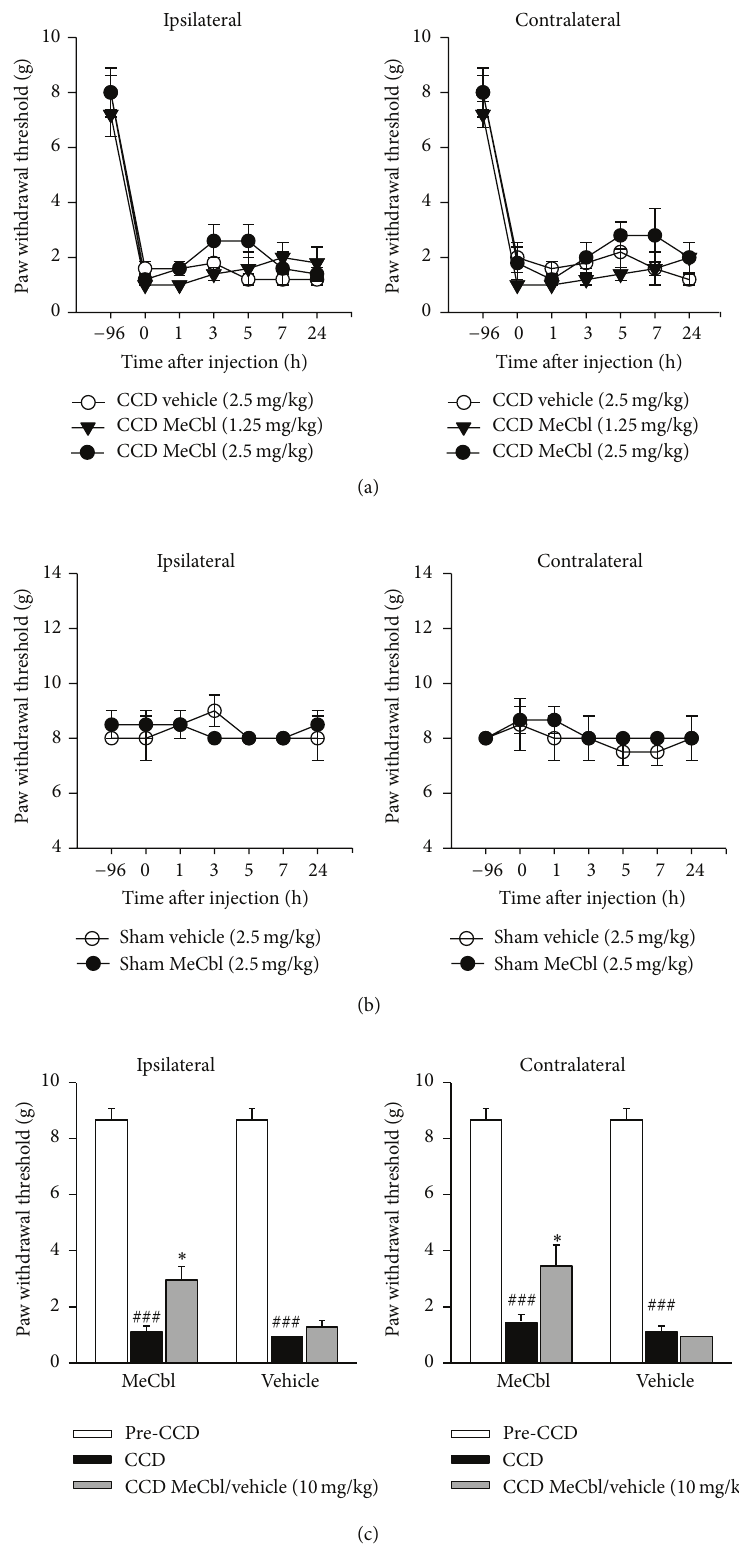
Figure 1: High dose of MeCbl ameliorated mechanical allodynia of rats following the CCD in the short term. MeCbl (1.25 mg/kg, 2.5 mg/kg, and 10mg/kg) was injected intraperitoneally on the postoperative 3 to 10 days. (a) Effects of MeCbl on ipsilateral and contralateral mechanical paw withdrawal thresholds in CCD rats following the injection. (b) No effects of MeCbl on ipsilateral and contralateral mechanical paw withdrawalthresholdsinshamrats.(c)AhigherconcentrationofMeCblaffectedbilateralpawwithdrawalthresholds. ### 𝑃 < 0.001 ,compared to those in pre-CCD group; ∗ 𝑃 < 0.05 , compared with those of CCD